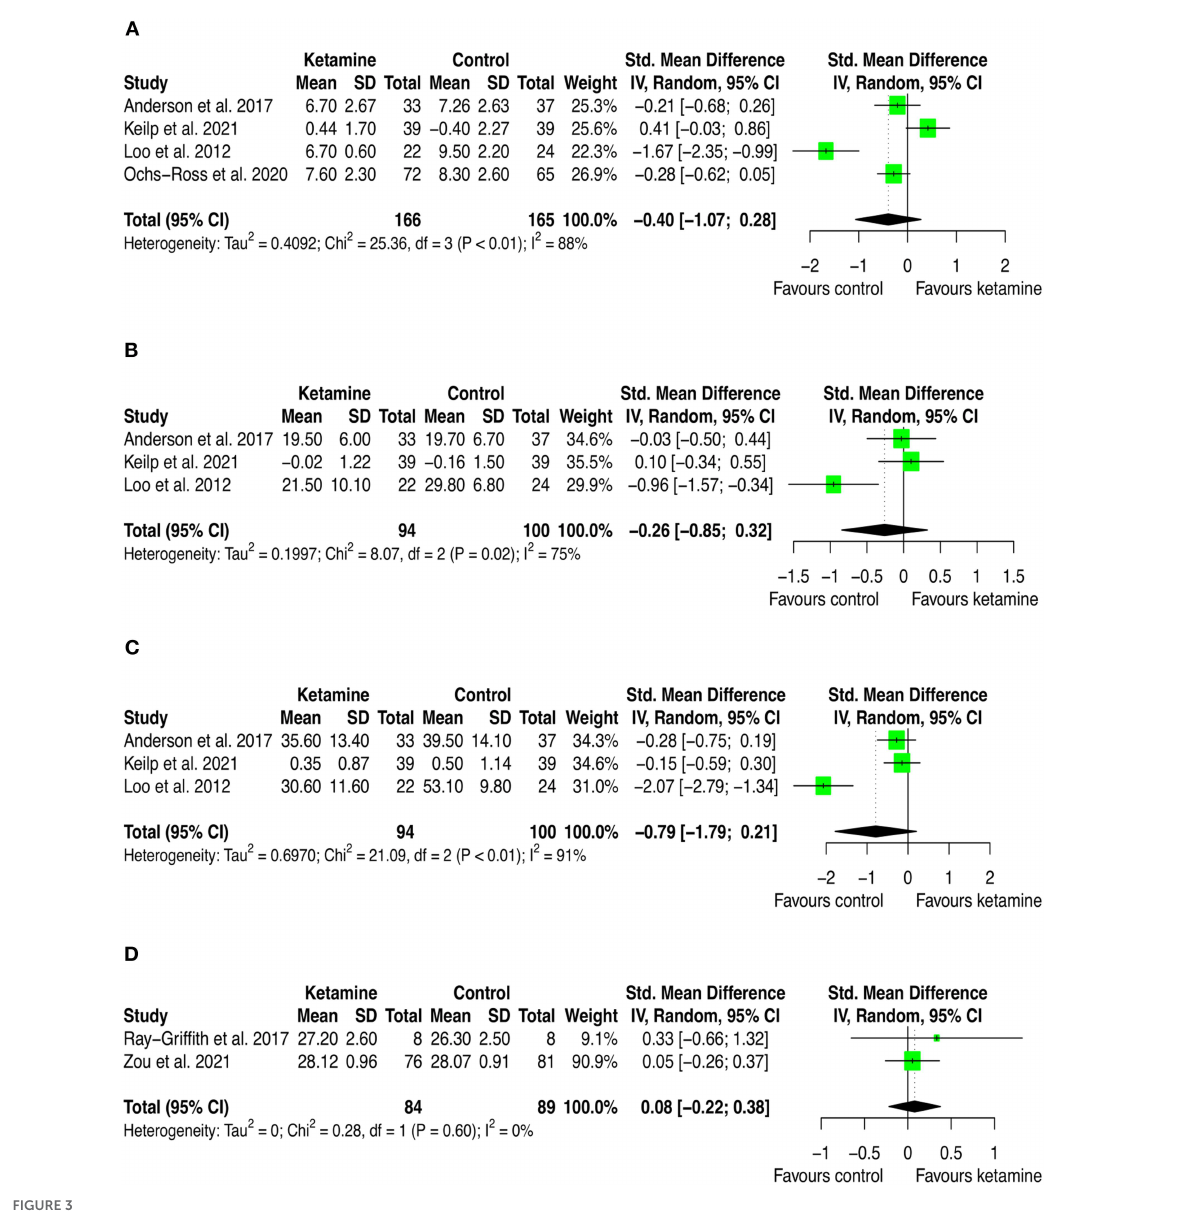
FIGURE3 Forest plots of performance comparisons among experimental and control groups on Delayed recall (A) , Immediate recall (B) , Letter fluency (C) , Mini mental state examination (MMSE) (D) . SD, standard deviation; IV, inverse variance; 95% CI, 95% confidence interval. x axis labels have been edited according to the characteristics of the outcome: since higher scores indicate better performance the label “Favors ketamine” is on the right-hand